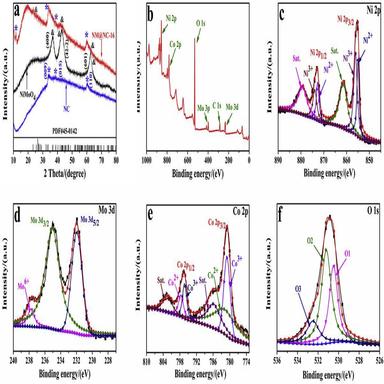
XRD patterns of the samples (a); XPS spectra of the NM@NC-16: survey spectrum (b), Ni 2p (c), Mo 3d (d), Co 2p (e) and O 1s (f).